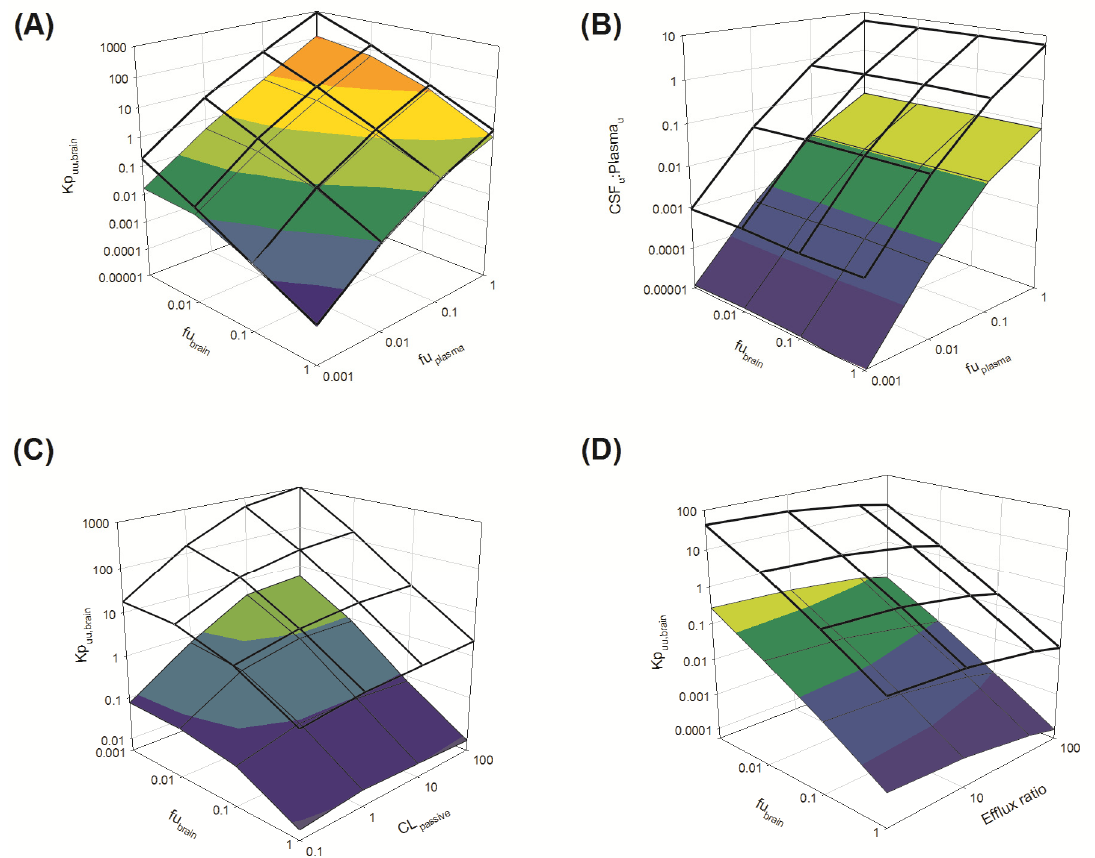
Figure 7. Sensitively analysis of the whole-body physiologically based pharmacokinetic (PBPK) model. The impact of variations in f u K p and CSF :Plasma uu,brain u u